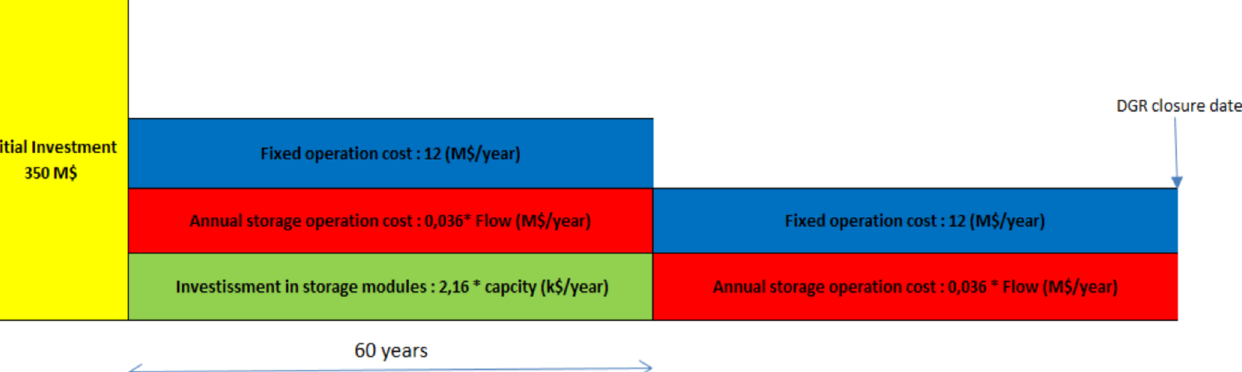
Fig. 4. Breakdown of interim storage costs.